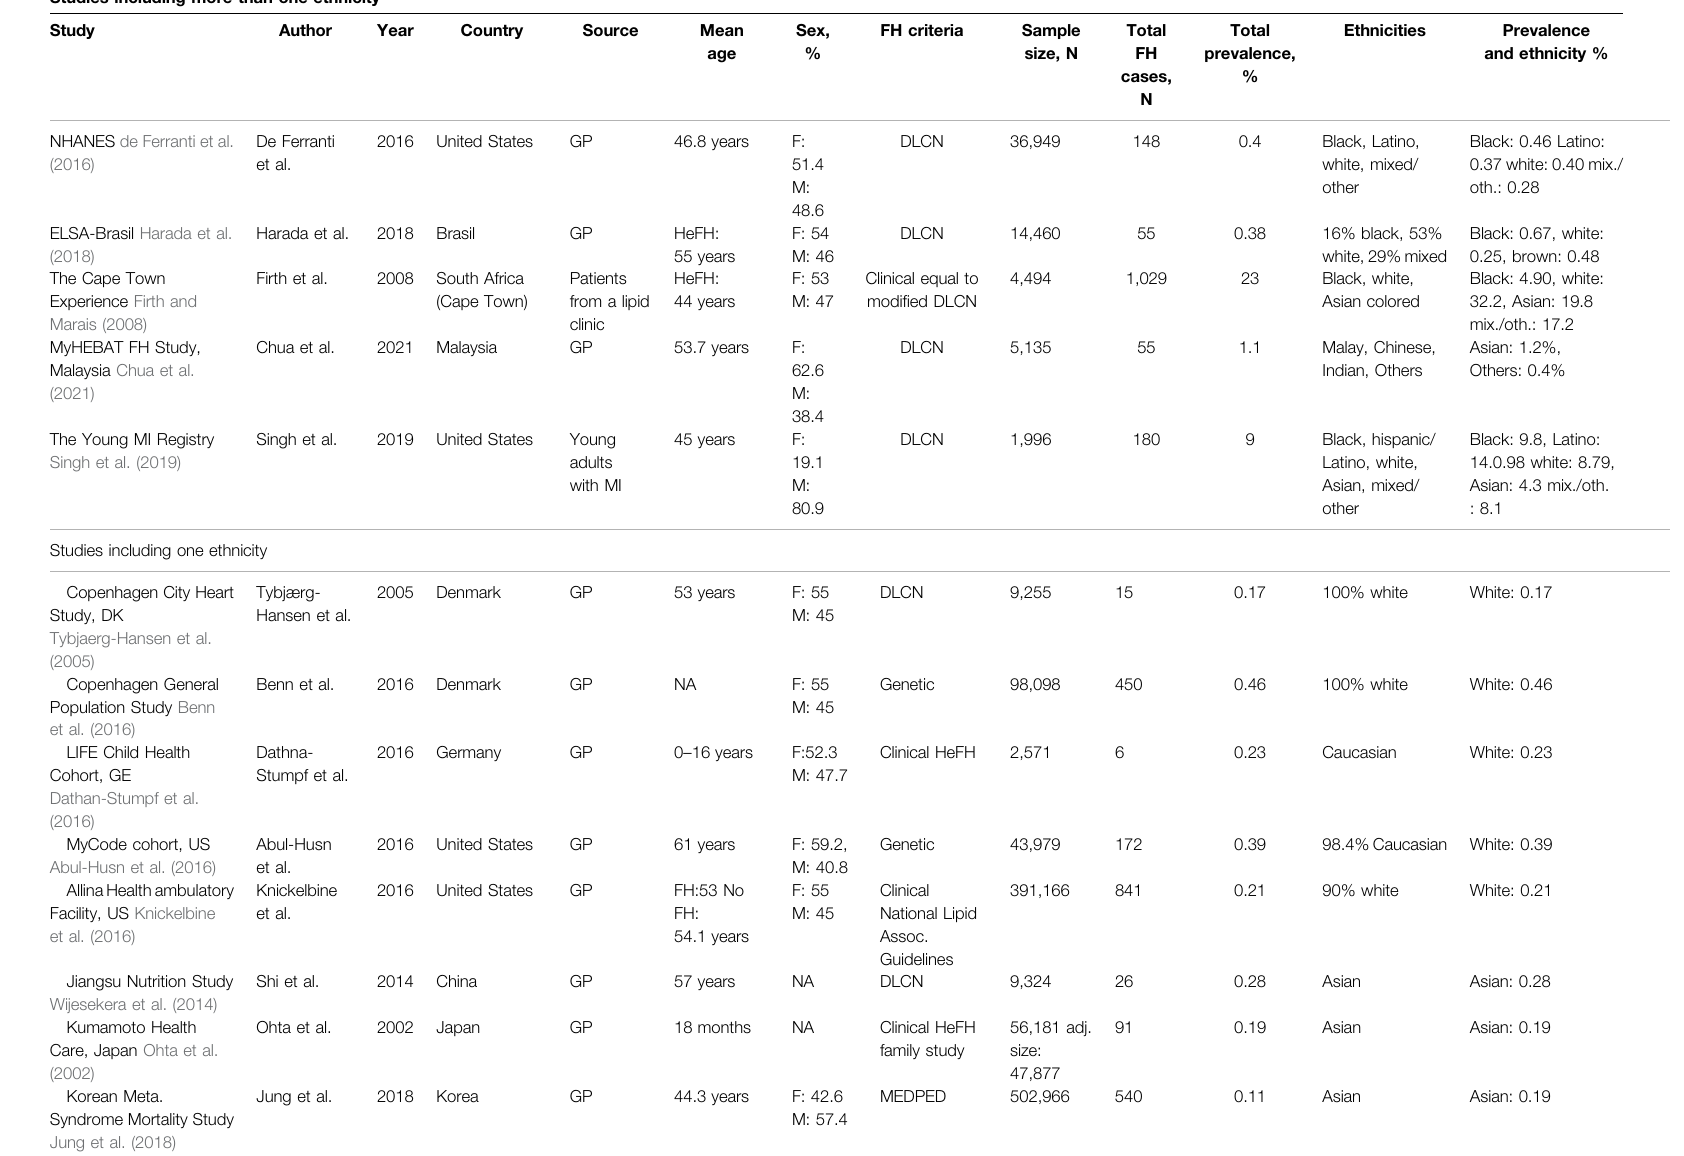
TABLE 1 | Characteristics of all studies included in the systematic review and